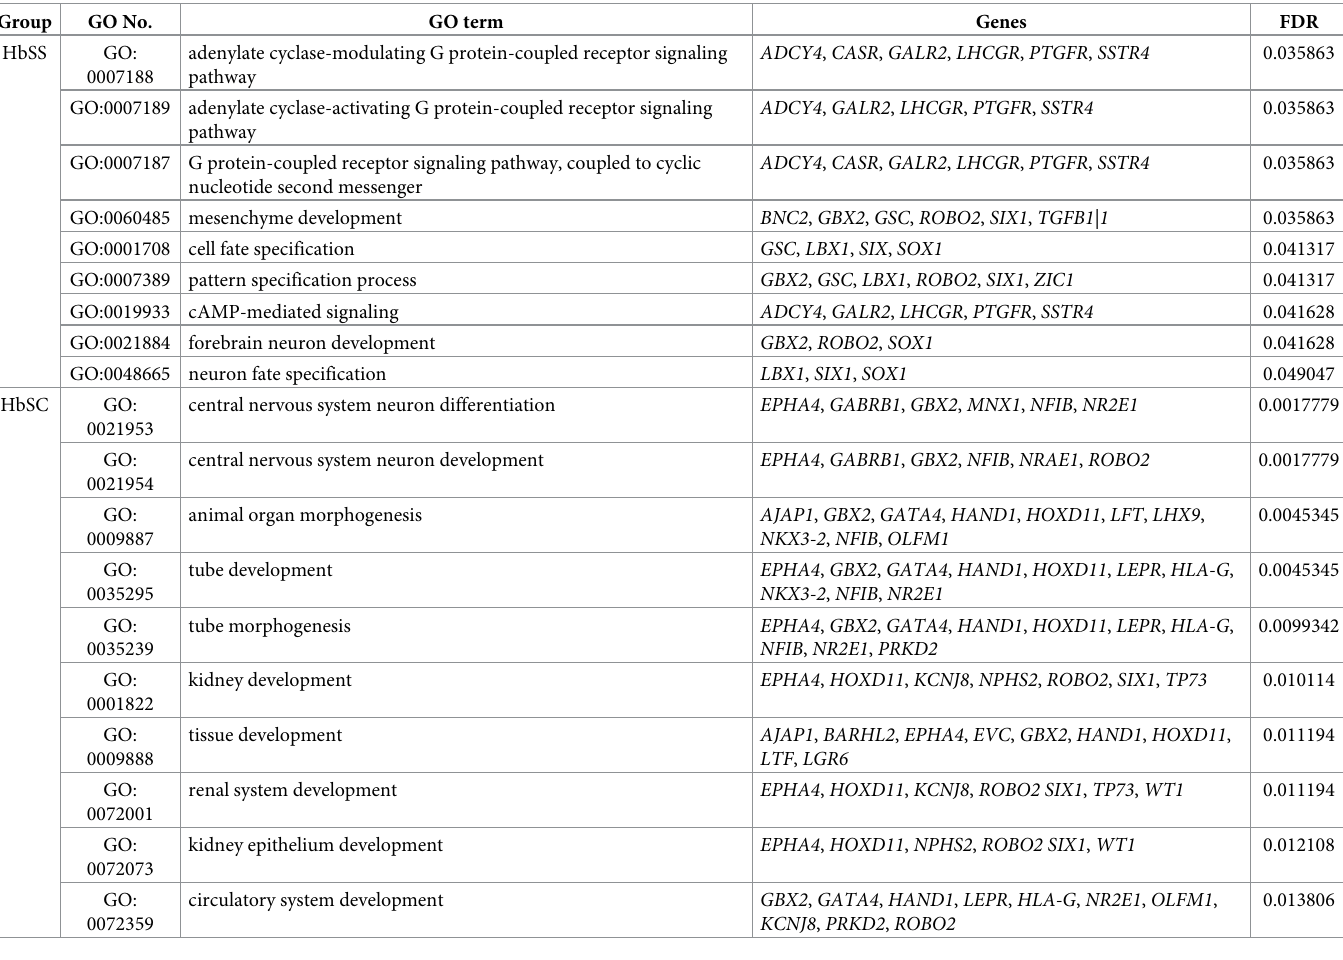
Table 4. The GO terms for differentially methylated genes between cases (HbSS and HbSC) and controls groups. GALR2 , PTGFR , ADCY4 . Group GO